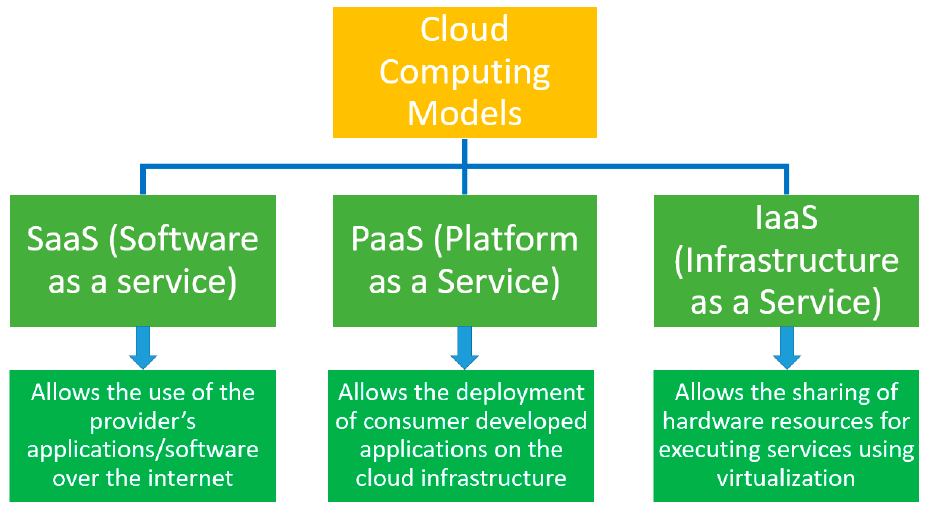
Figure 5. Models for cloud computing.